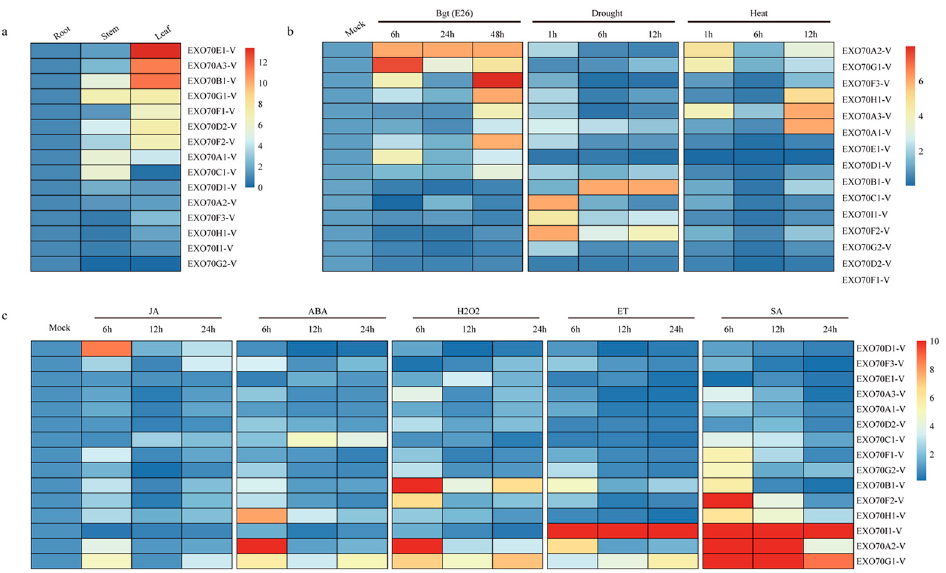
Figure 6. Heat map of the expression profiling of wheat and H. villosa EXO70 genes in tissues and in response to biotic/abiotic stress, phytohormones and H 2 O 2 treatments. ( a ) Tissue-specific pattern of 15 EXO70-V genes in H. villosa . ( b ) Expression levels of EXO70-V genes in biotic/abiotic stresses of H. villosa . ( c ) Expression profiling of EXO70-V genes in response to phytohormones and H 2 O 2 treatments. The scale bar showing expression level of the genes. Abbreviations: Bgt , powdery mildew; SA, salicylic acid; MeJA, methyl jasmonate; ET, ethephon; ABA, abscisic acid; H 2 O 2 , hydrogen